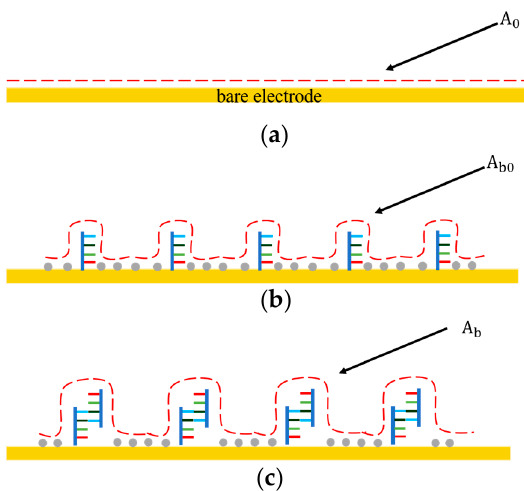
Figure 2. The interfacial capacitance changes at different stages of probe immobilization and miRNA ‐ 16 binding. ( a ) Before probe immobilization. ( b ) After probe immobilization and blocking. ( c ) After miRNA ‐ 16b binding with DNA probe.